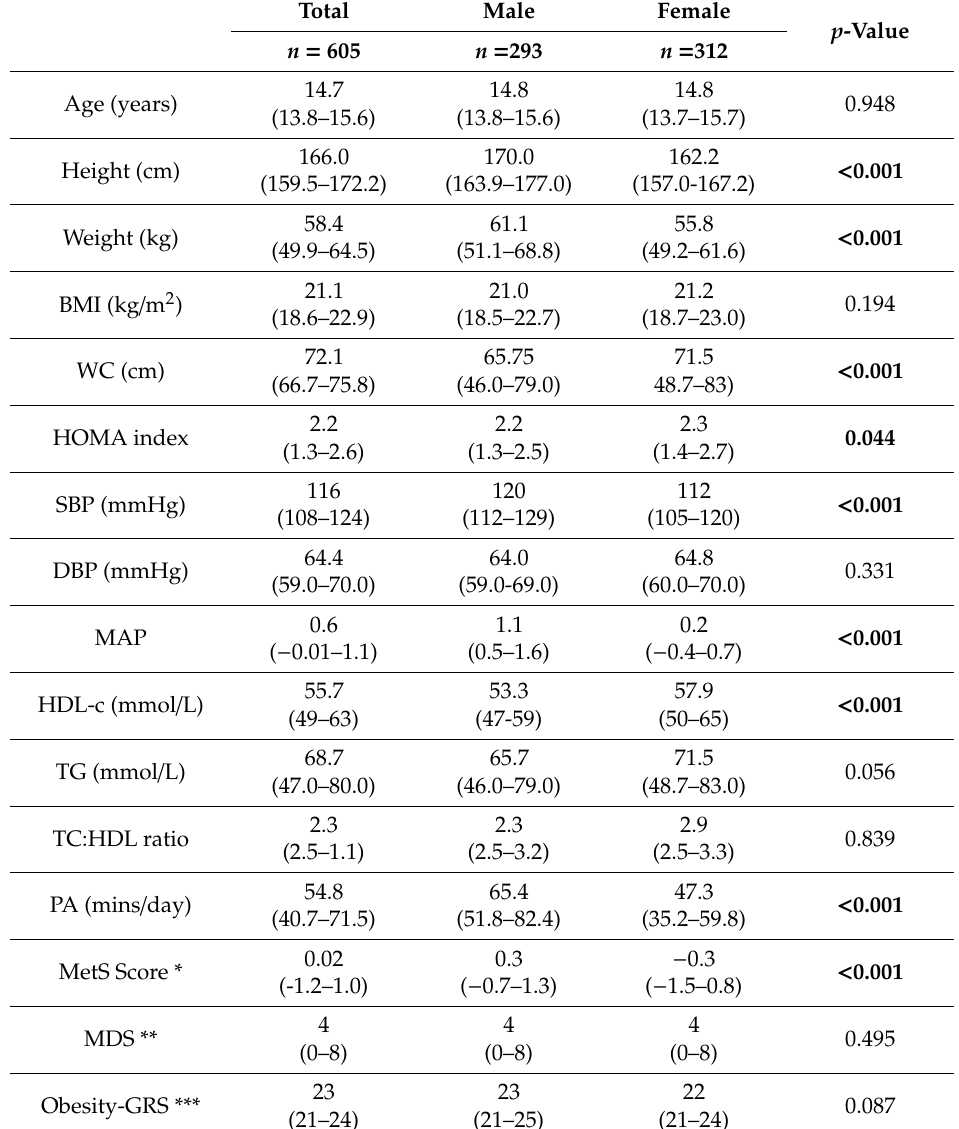
Table 1. Demographics and cardiometabolic characteristics of the Healthy Lifestyle in Europe by Nutrition in Adolescence (HELENA) participants displayed by